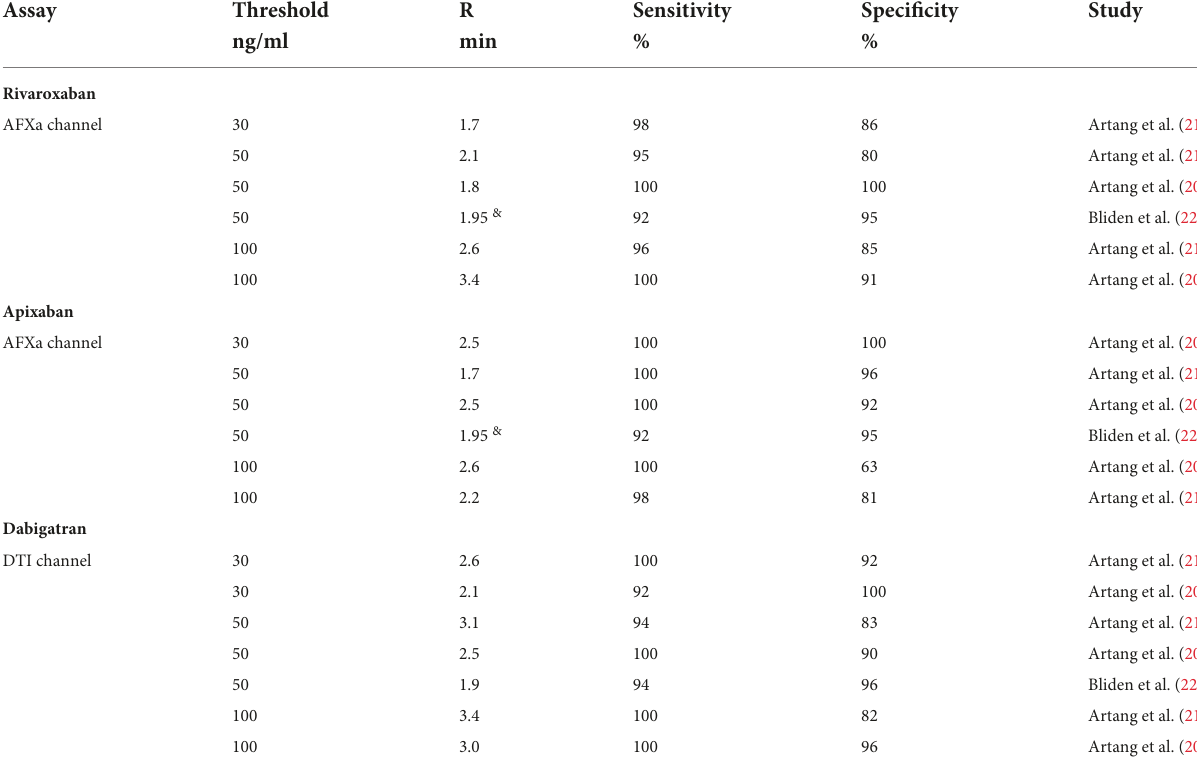
TABLE 1.2 Study defined TEG 6s reaction time (R) thresholds for detection of residual DOAC plasma concentration stratified by assays.